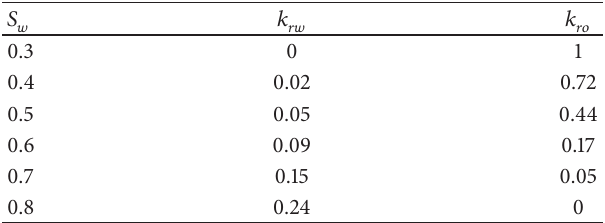
Table 2: Relation between the water phase saturation and relative